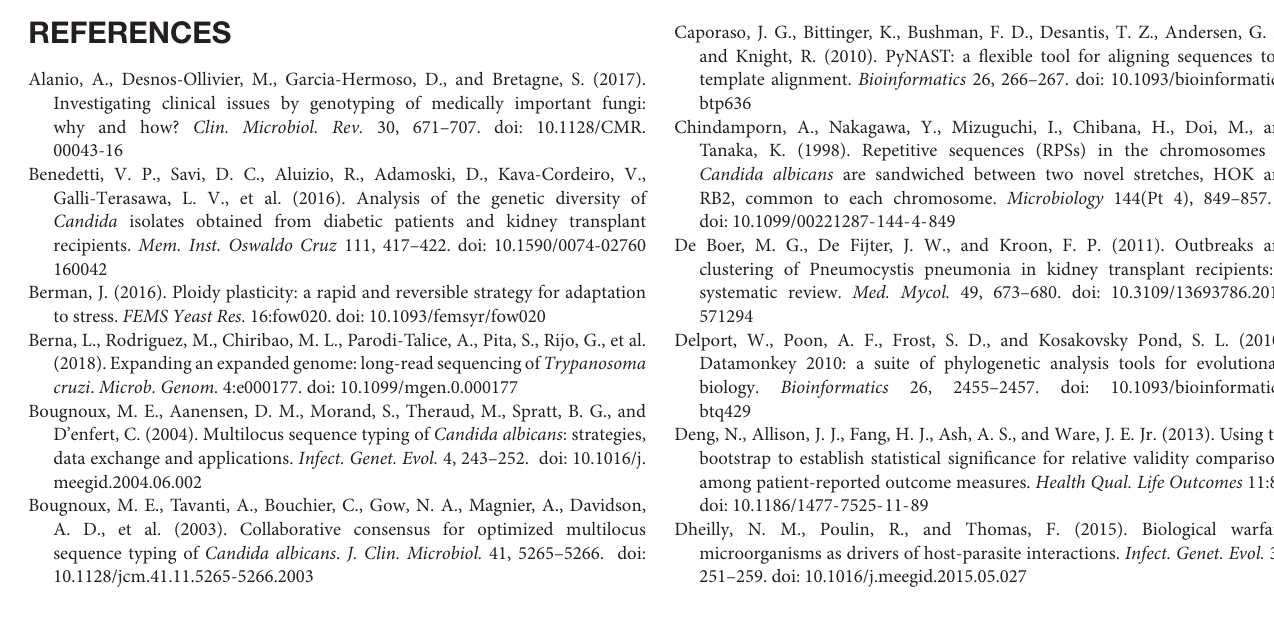
FIGURE S4 | Graphical representation of Clonal Complexes (CC) at micro geographical scale. FIGURE S5 | Phylogenetic reconstructions based on the total concatenated sequence using the RAxML method. FIGURE S6 | Phylogenetic trees generated from the alignments of the individual housekeeping genes. FIGURE S7 | Phylogenetic tree based on seven housekeeping genes’ concatenated sequences of 405 isolates from United Kingdom used for micro geographic analyses. FIGURE S8 | Results of the SplitsTree analysis over global population. FIGURE S9 | SplitsTree results at micro geographical scale. TABLE S1 | Analysis of linkage disequilibrium corresponding to recombination